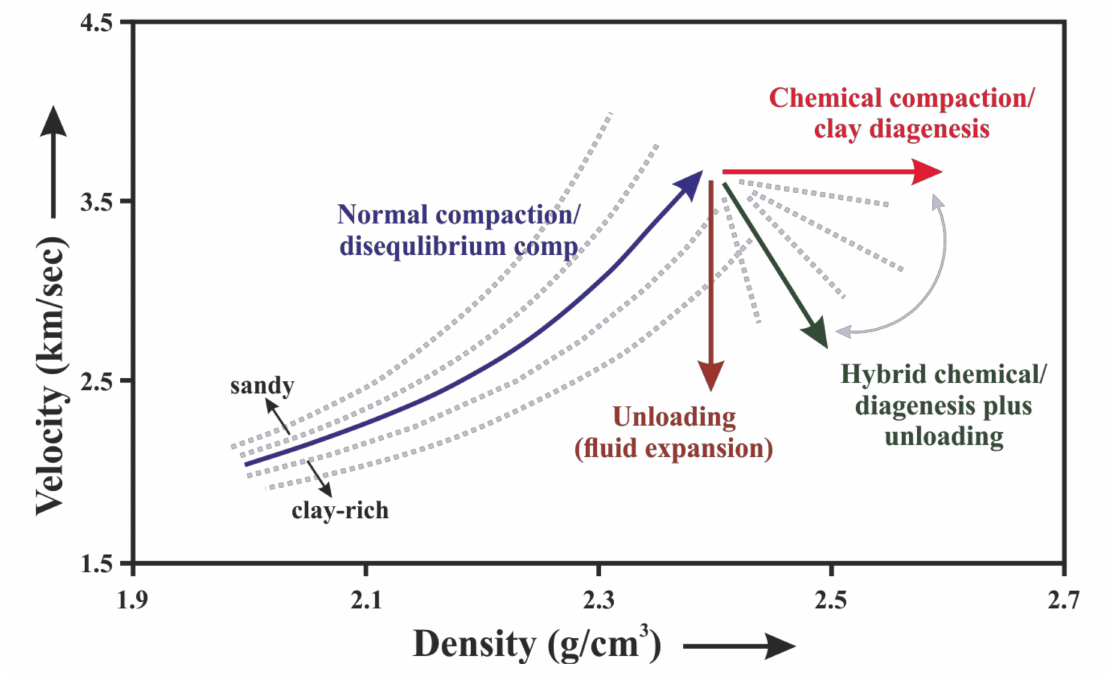
Figure 6. Bulk density and the compressional wave velocity routes in case of different overpressure generation mechanisms. Normal compaction and under-compaction result in the increase of compressional wave velocity and bulk density; thus, deviation from this route suggests the contribution of another